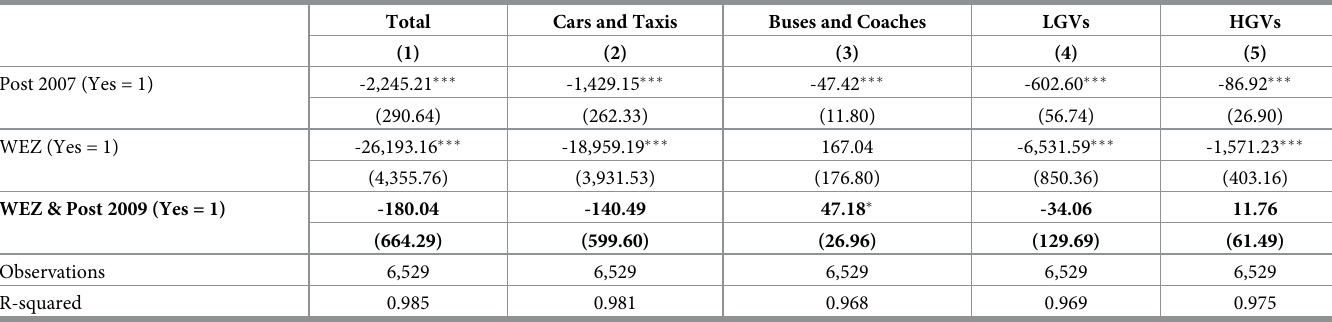
Table 3. Placebo test estimates—Removal of the